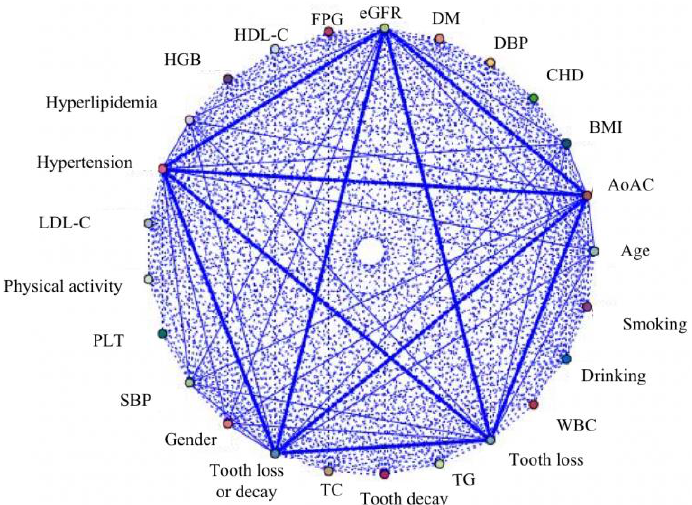
Figure 1. Visualization of the association rules based on the Apriori algorithm. The thickness of lines indicates the strength of the association rules. SBP indicates systolic blood pressure; DBP: diastolic blood pressure; BMI: body mass index; CHD: coronary heart disease; WBC: white blood cell count; HGB: hemoglobin; PLT: platelet; TC: total cholesterol; TG: triglyceride; LDL-C: low-density lipoprotein cholesterol; HDL-C: high-density lipoprotein cholesterol; FPG: fasting plasma glucose; eGFR: estimated glomerular filtration rate.